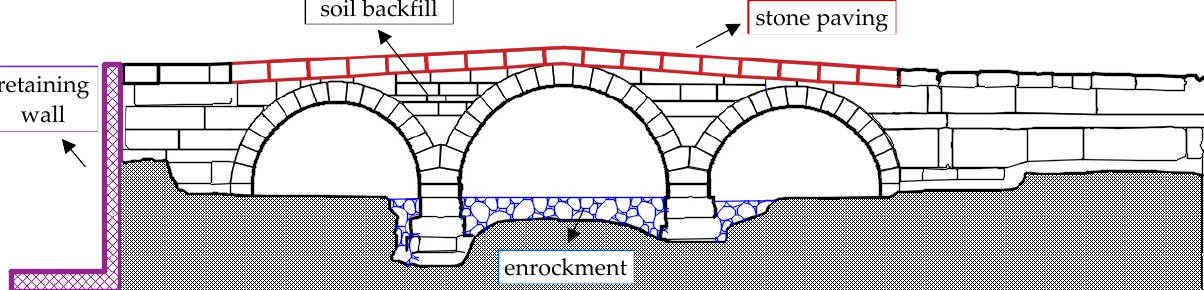
Figure 14. Retrofitting measures taken for the bridge.